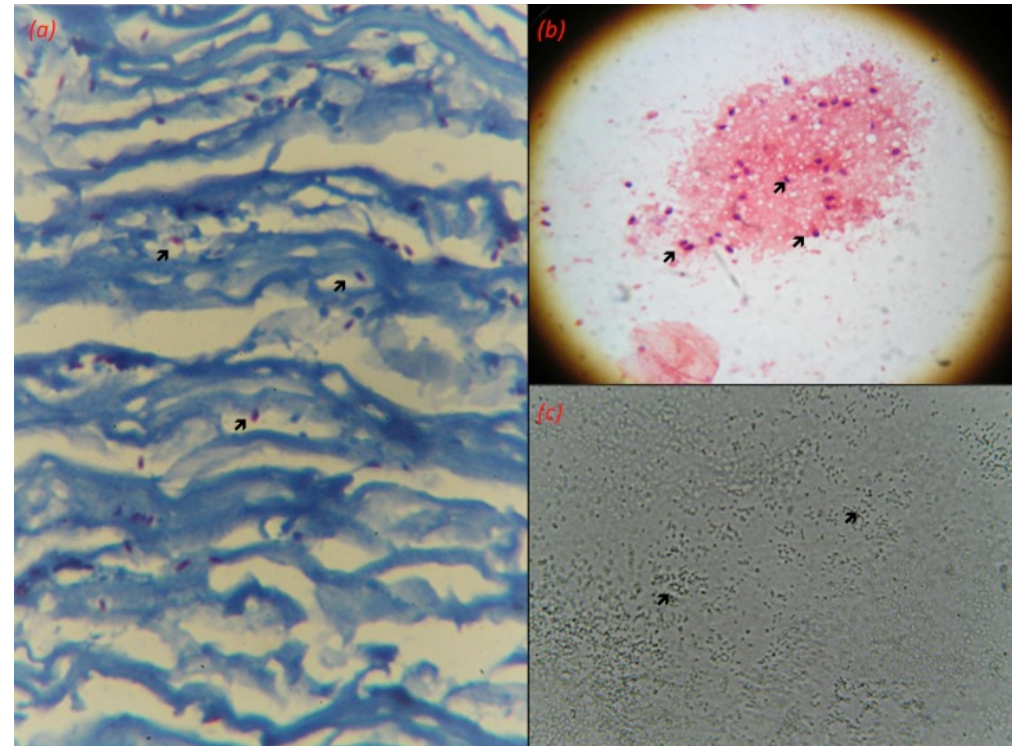
Figure 4: (a) Microsporidial spores (black arrow) seen as well-defined oval reddish bodies on Ziehl Neelsen stain of the corneal button derived from the first patient. (b) Gram’s stain of the second patient showing microsporidial spores (black arrow). (c) Potassium hydroxide (KOH) 10% depicting well defined microsporidial spores (black arrow), obtained from corneal scraping from the third